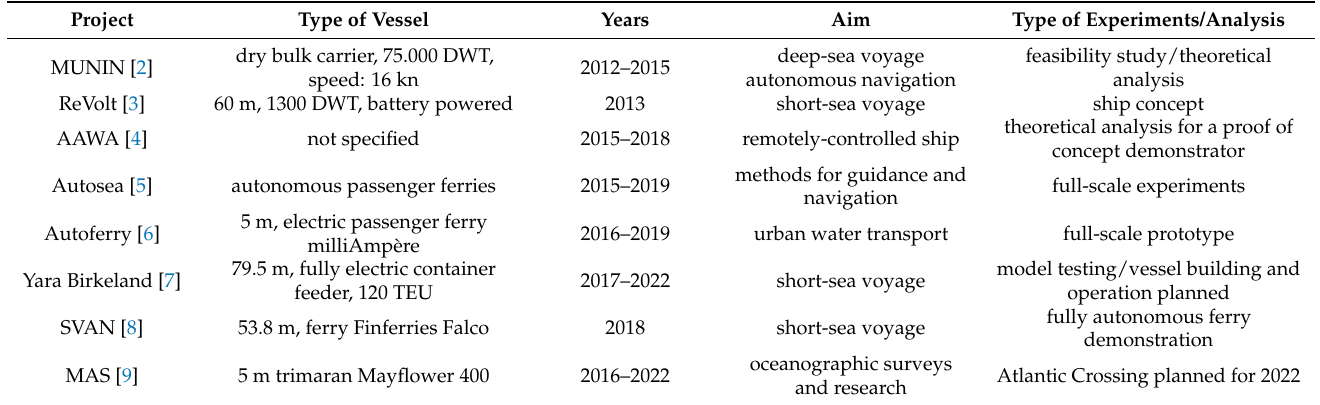
Table 1. Research projects on autonomous ships.